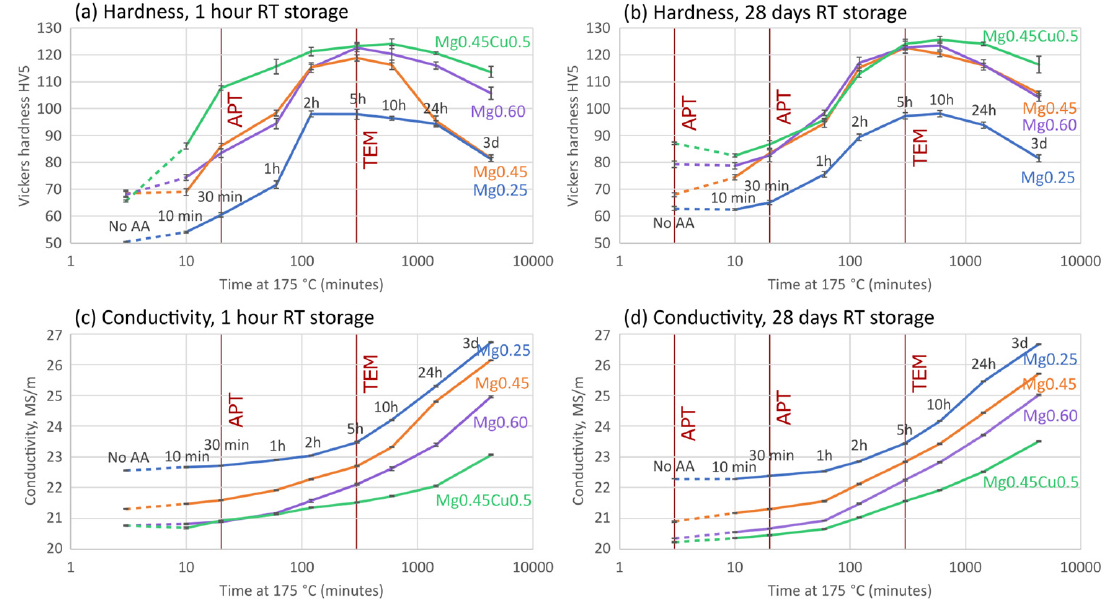
Figure 2. Aging curves after 1 h/28 days RT storage and subsequent AA. ( a , b ) Vickers hardness, averaged over 5 measurements. Error bars show standard errors. ( c , d ) Electrical conductivity, averaged over 5 measurements. Errors are too small to show in this plot.